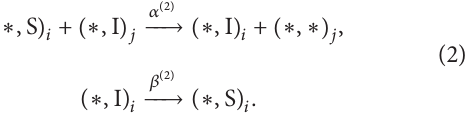
Figure2:Thevirusspreadthreshold 𝜆 𝐶 asafunctionoftheimmune success rate 𝛿 on the finite size BA networks, for the different effective transmission rate 𝜆 2 of immunization agent. Network node number 𝑁 = 2000 and edge number from each new node 𝑚 = 5